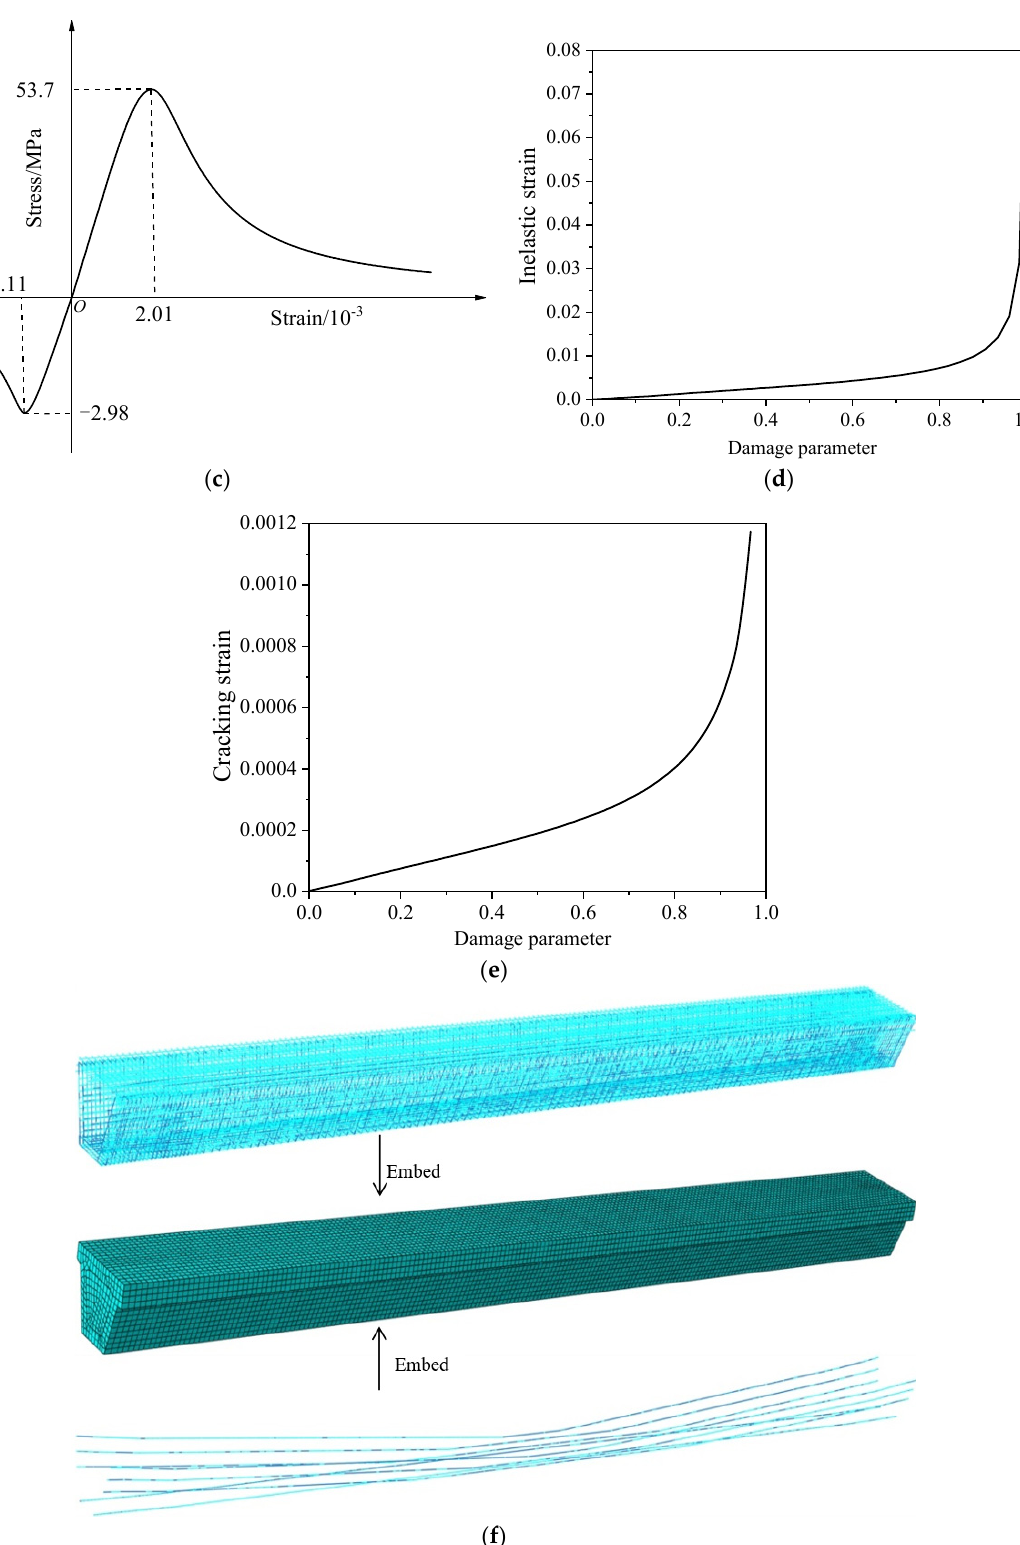
Figure 9. The refined finite element model of the box girder. ( a ) Stress vs. strain curve of reinforcements; ( b ) Stress vs. strain curve of pretensioned strands; ( c ) Stress vs. strain curve of concrete; ( d ) Compression damage of concrete; ( e ) Tension damage of concrete; ( f ) Finite element